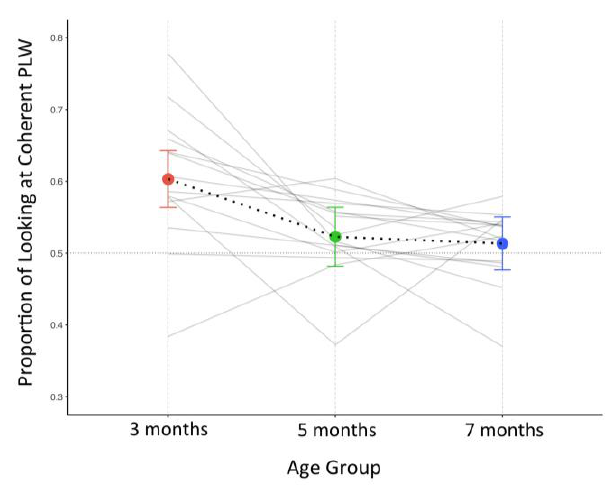
Figure 4. Model-based mean estimates of proportion of looking at the coherent point-light walker at three (orange), five (green) and seven (blue) months of age superimposed onto infants’ longitudinal raw data (in grey). The horizontal dotted line denotes the 0.5 proportion, (i.e., equal looking at both stimuli) and no preference. Error bars are displayed through mean dots.